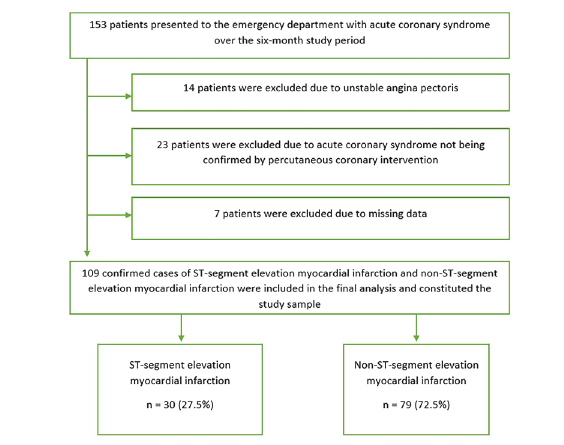
Figure 1 - Flowchart of the